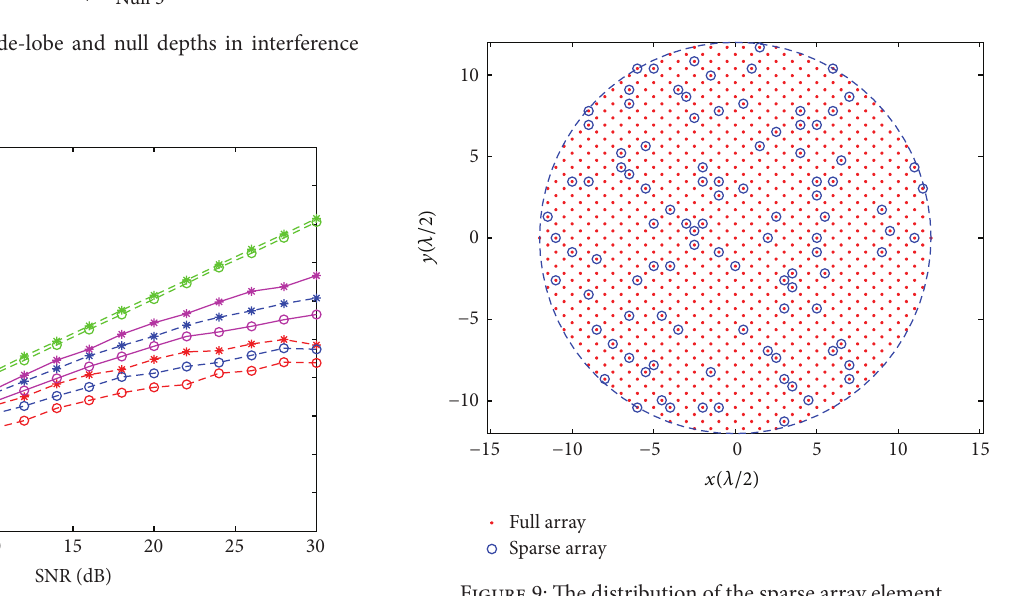
Figure 8: The beam pattern of DOAs not on the grid.